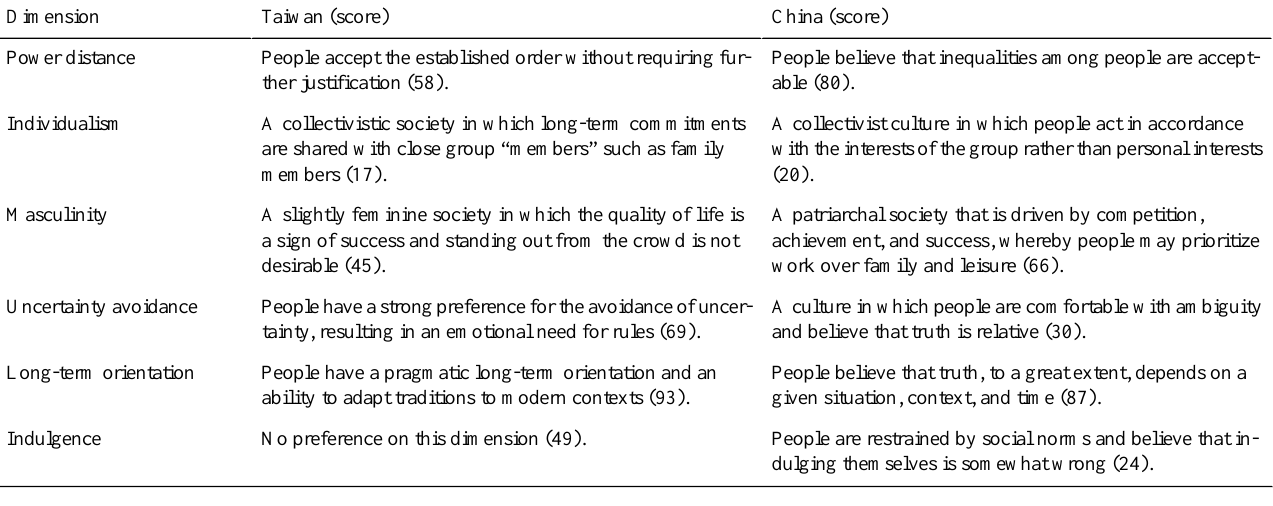
Table 1. Six-dimensional model of the national culture of Taiwan and China based on Hofstede [7]. (58).Power distance